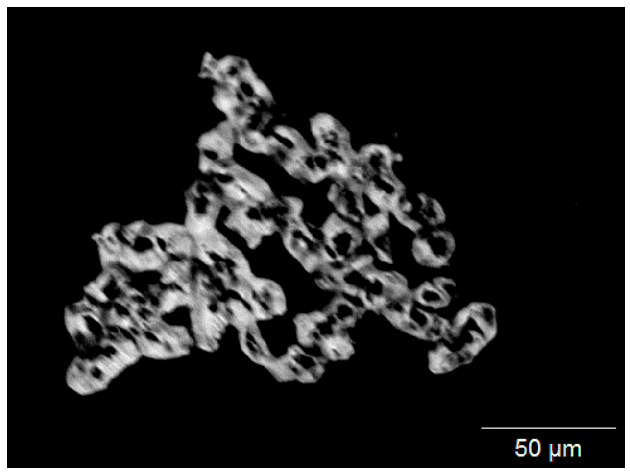
Figure 2. Aggregate of siderazot, BSE (backscattered electron) image of a grain mount (not polished). Note the granular surface structure. The sample appears to be composed of numerous small spheres with degassing vents.